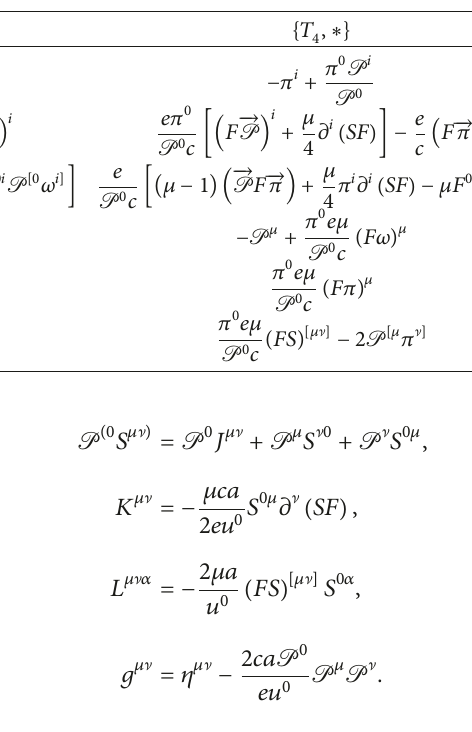
Table 2: Auxiliary Poisson